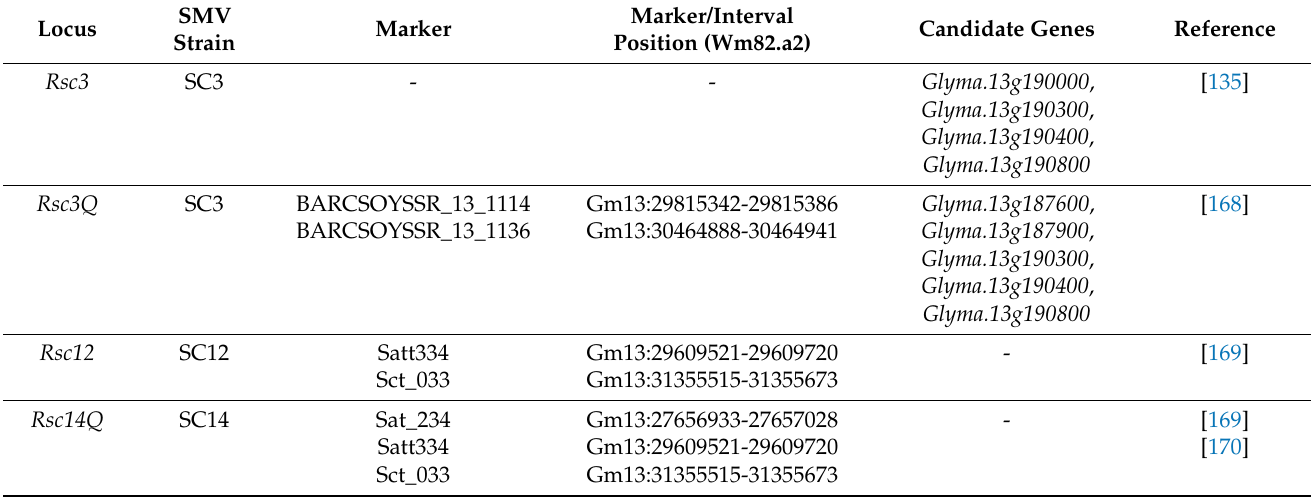
Table 4. Summary molecular markers and candidate genes for resistance to Soybean mosaic virus strains in